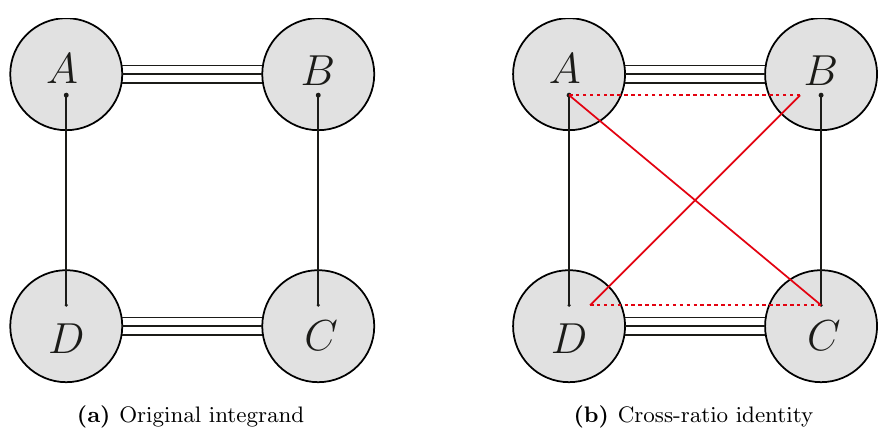
Figure 1. Con(cid:12)guration of the original integrand and the cross-ratio identity of the rule I. Four red lines represent the term z ia 0 z jc 0 provided by the cross-ratio z ij z a 0 c 0